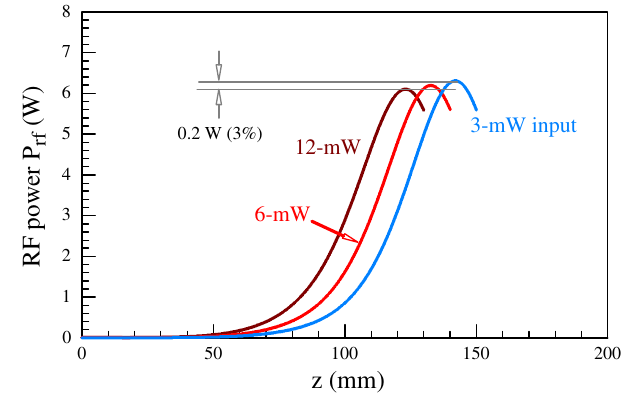
FIG. 14. (Color) The rf power profiles for different input rf powers. The saturated rf powers are, respectively, 6.3 W at z (cid:3) 142 mm for a 3-mW input, 6.2 W at z (cid:3) 133 mm for a 6-mW input, and 6.1 W at z (cid:3) 123 mm for a 12-mW input.